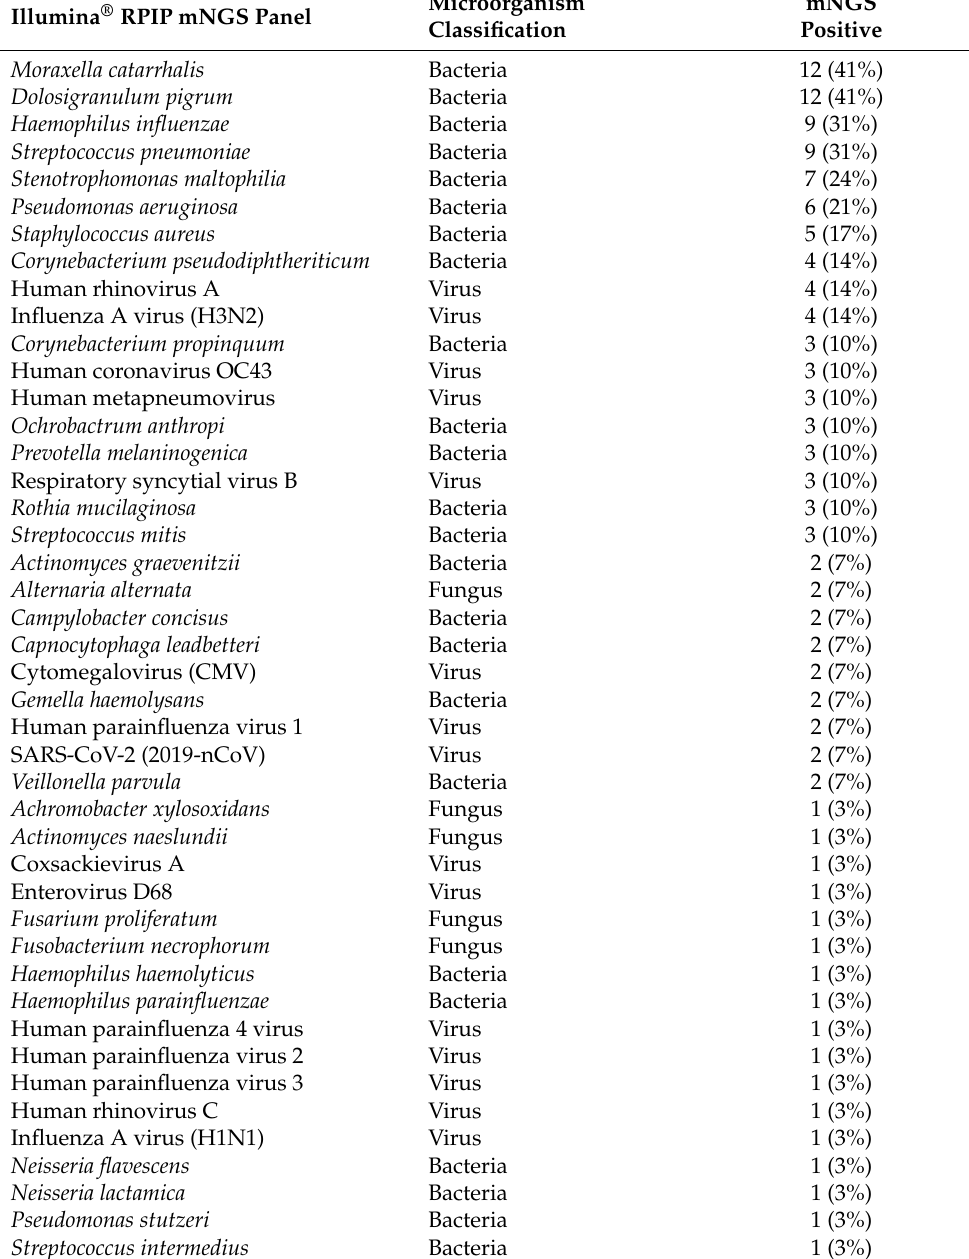
Table 2. Illumina ® RPIP mNGS panel positive